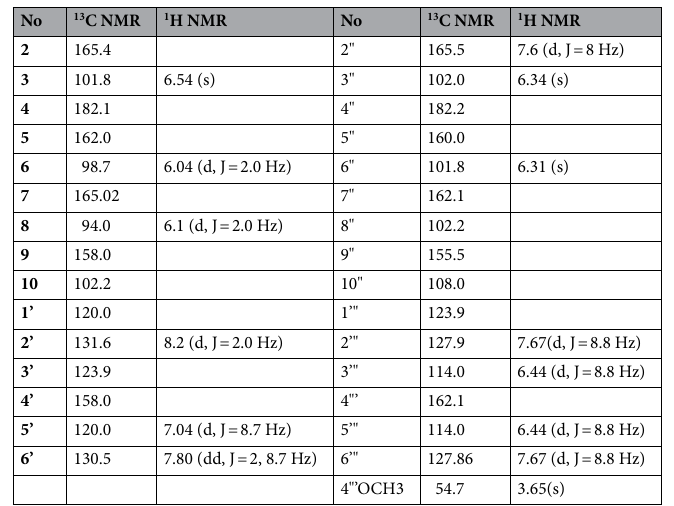
Table 2. 1 H NMR and 13 C NMR spectrum of compound A in acetone-d